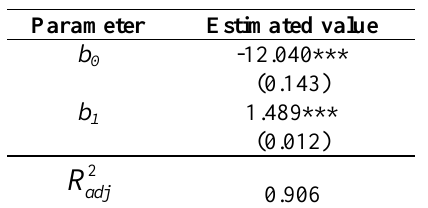
Table 4 : Estimation results for Equation